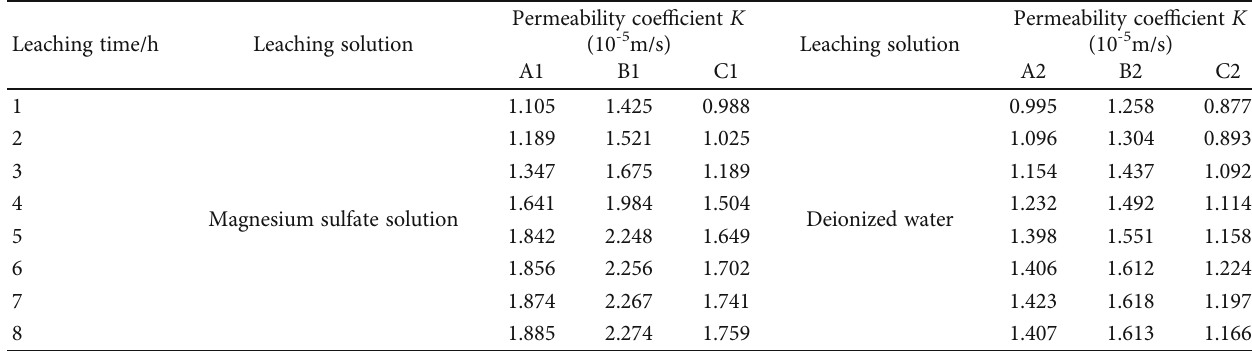
Table 5: Permeability coe ffi cient of samples in each stage of leaching